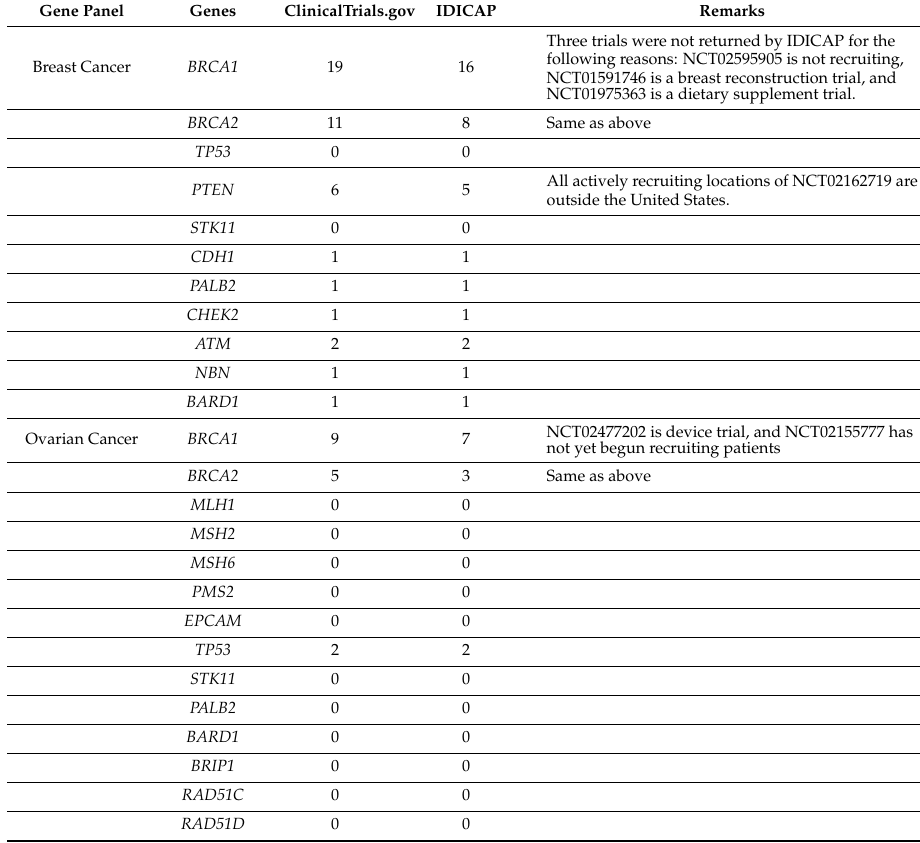
Table 1. Comparison of search results returned by IDICAP (Integrated Drug Intervention for CAncer Panel) and ClinicalTrials.gov. Columns ClinicalTrials.gov and IDICAP indicate the number of trials returned by the query of a gene with aforementioned search